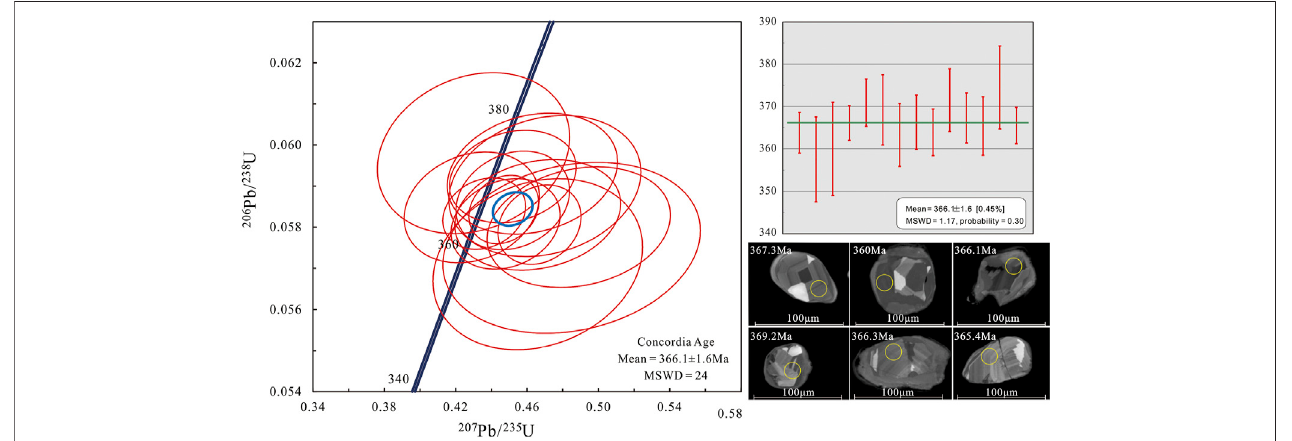
FIGURE 8 | Concordia plot of LA-ICP-MS U – Pb analyses and CL images of zircons from the gabbro in the south margin of Hongshishan intrusion.